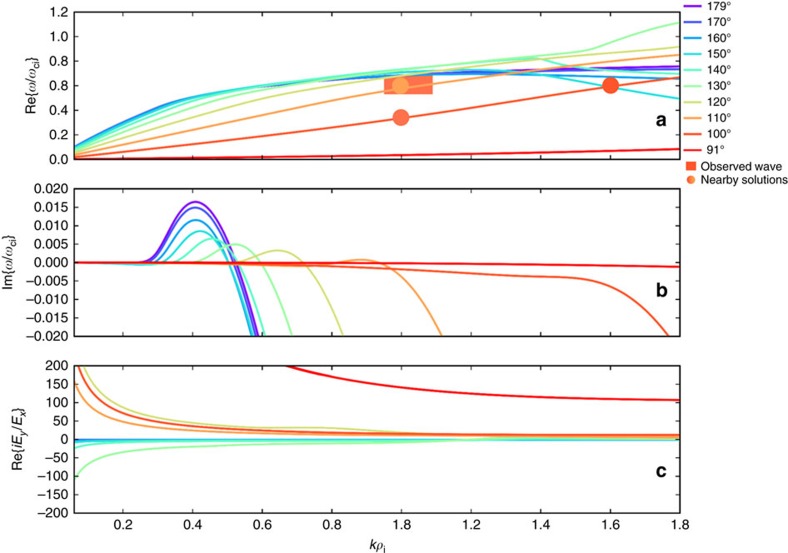
Modelled dispersion curves for the local plasma environment.(a) The real part of ω/ωci, that is, the wave oscillation frequency, (b) the imaginary part of ω/ωci, that is, the wave growth/damping rate and (c) the real part of iEx/Ey, that is, the polarization of the wave, as a function of scaled wavevector magnitude kρi. Coloured curves correspond to solutions of a linear dispersion relation solver taken along the Alfvén branch for different wavevector angles (θ) relative to the background magnetic field. The fastest growing wave mode has a wavevector parallel/anti-parallel to the background magnetic field (that is, θ=0°, 180°) at ω/ωci∼0.5 and kρi∼0.4 and is left-hand polarized (that is, Re{iEx/Ey}<0). A transition to right-hand polarization (that is, Re{iEx/Ey}>0) occurred at θ∼130°. No strong growth or damping was predicted for the observed KAW (θ=104±4°, ω/ωci=0.61±0.08 and ρi=1.02±0.07), indicated with the shaded area in (a). The dimensions and colour of the shaded area correspond to the reported uncertainties of the measured ω/ωci and ρi parameters and θ≈100°, respectively Nearby solutions that match two of the measured {ω/ωci, kρi, θ} parameters (but not all three) are shown as solid circles. The colour of each circle corresponds to the wavevector angle.